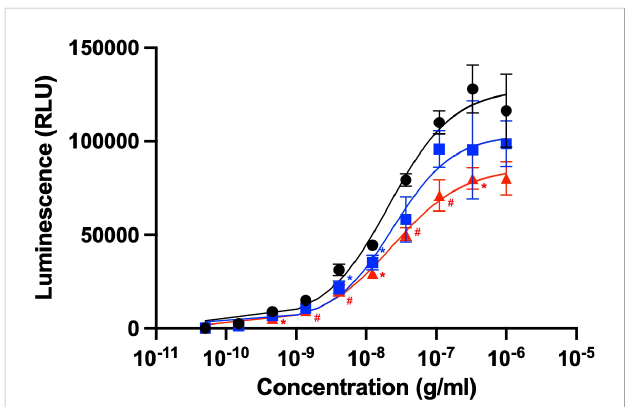
FIGURE 1 Rituximab-mediated ADCC activity in fl uenced by the presence of serum components. ADCC activity of rituximab was measured in the absence (black circle) or presence of HSA (red triangle) or polyclonal IgG-Fab (blue rectangle). Rituximab concentration was prepared as a series of 3-fold dilutions from 1 m g/mL. Final concentrations of HSA and polyclonal IgG- Fab were 600 m M and 240 m M, respectively. Data represent the mean±SD (n=3). Signi fi cant p -values (* p <0.05, # p <0.01) are compared to the control by two-way ANOVA followed by Tukey ’ s multiple